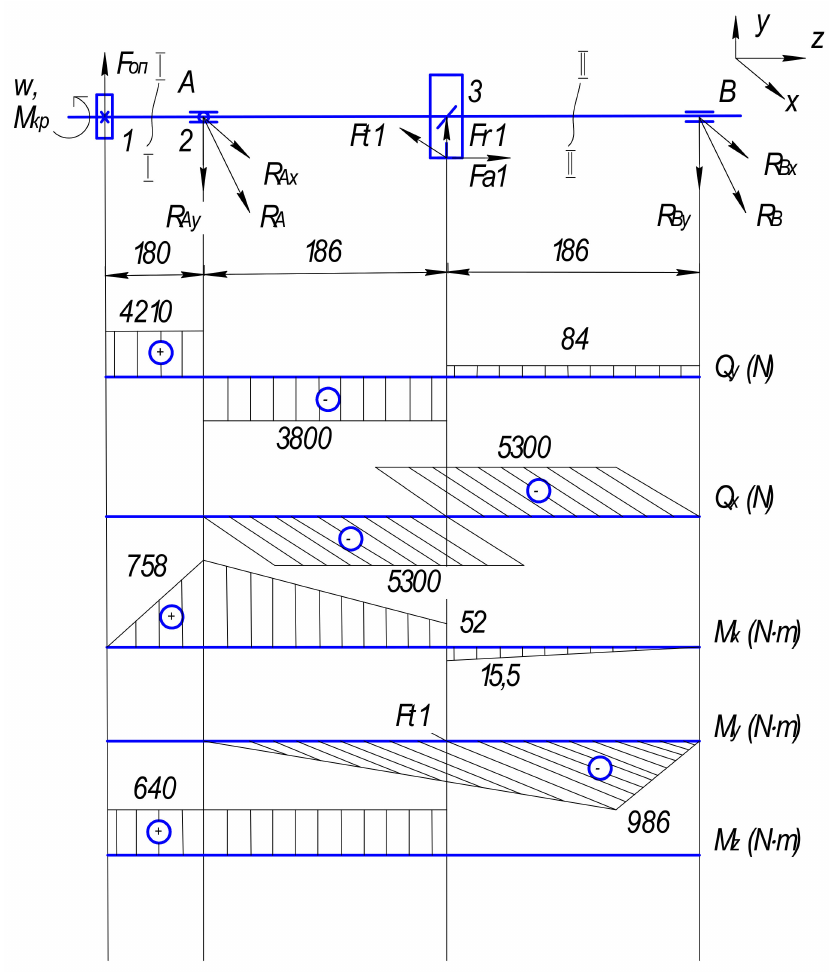
Figure 3. Design scheme of the shaft with plotting bending and torsional torques: x, y, z are coordinate systems of axes; I, II are shaft sections; A, B are designations of bearings on the shaft; w, Mt is the torque; 1, 2, 3 are shaft sections; Fog is the cantilever force from the belt drive; Ft1, Fr2, Fa1 are the directions of forces on the gear and on the wheel; RA , RAx , Ray, RB , RBx , RBy are the directions of radial reactions in bearings A, B , respectively; Qy, Qx are transverse forces; Mx, My, Mz are bending